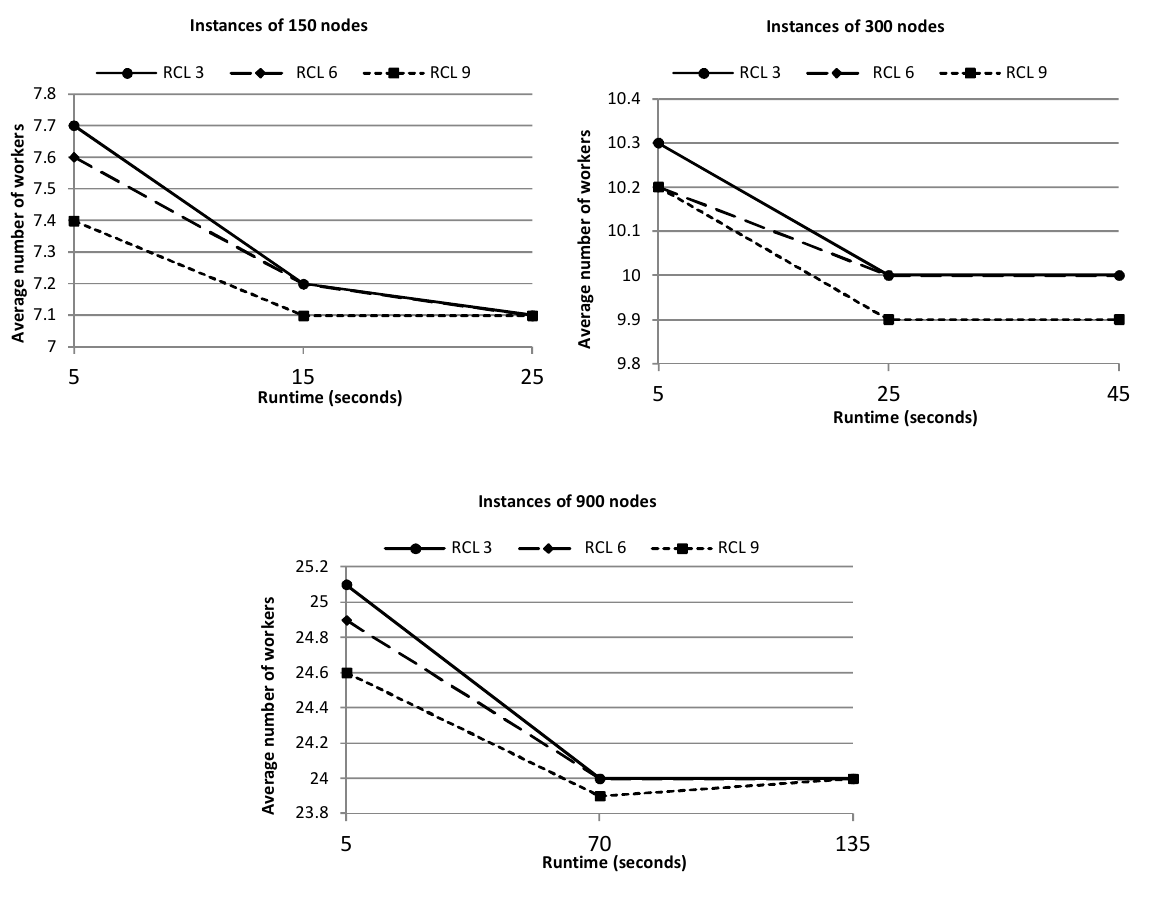
Fig. 3. Interaction plots Runtime (B) – RCL size